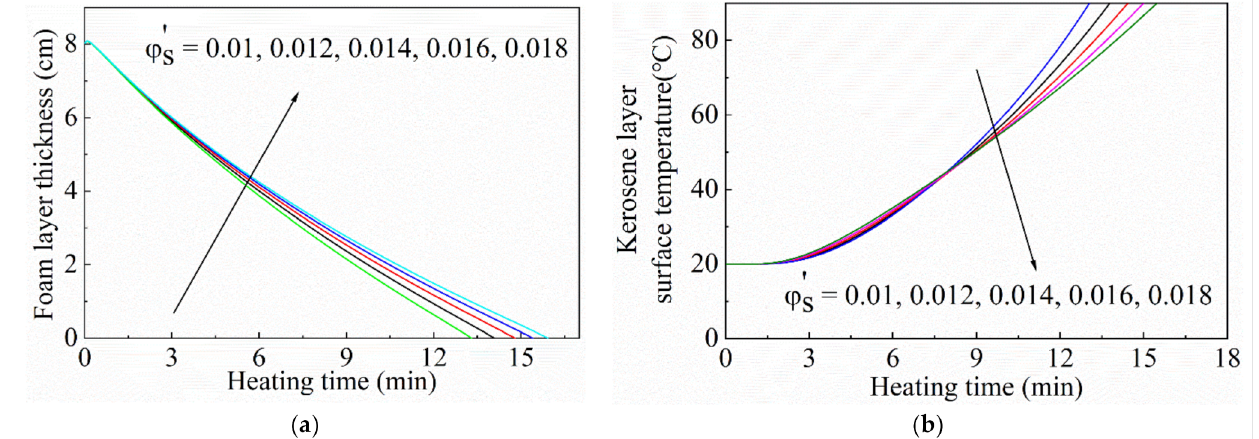
Figure 9. Curves of ( a ) the foam layer thickness and ( b ) surface temperature of the kerosene layer with different nanoparticle concentrations. The particle size was 30 nm. Initial thickness of the foam layer was 8.0 cm.